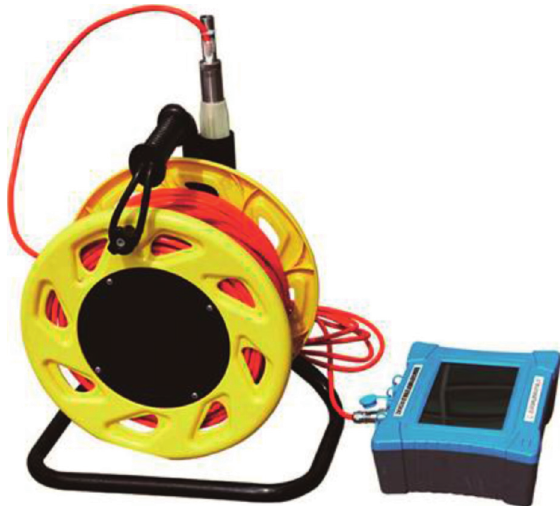
Figure 6: ZKXG30 mine safe drilling trajectory detection device.